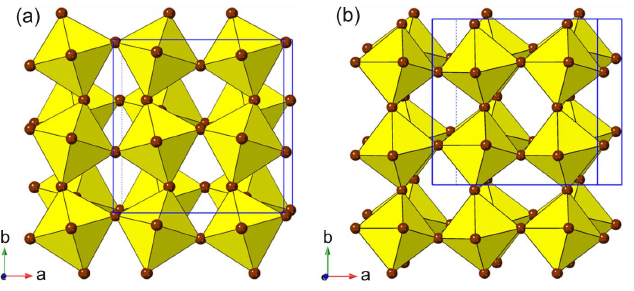
Figure 9 Comparison of two structures having the same unit-cell metrics (2 a RP (cid:3) 2 a RP (cid:3) c RP ) and space group C 2/ c , but exhibiting significantly different resultant tilt and shift behaviour ( a ) [C 4 H 14 S 2 N 2 ]PbBr 4 (628793) and ( b ) [C 2 H 4 N 3 ] 2 PbBr 4